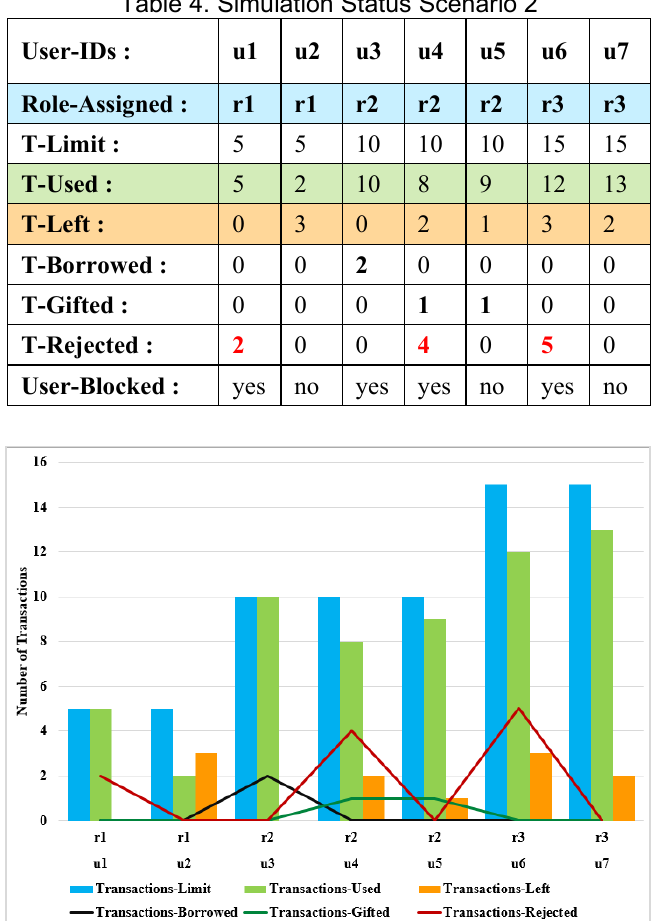
Figure 8. Simulation Status Scenario